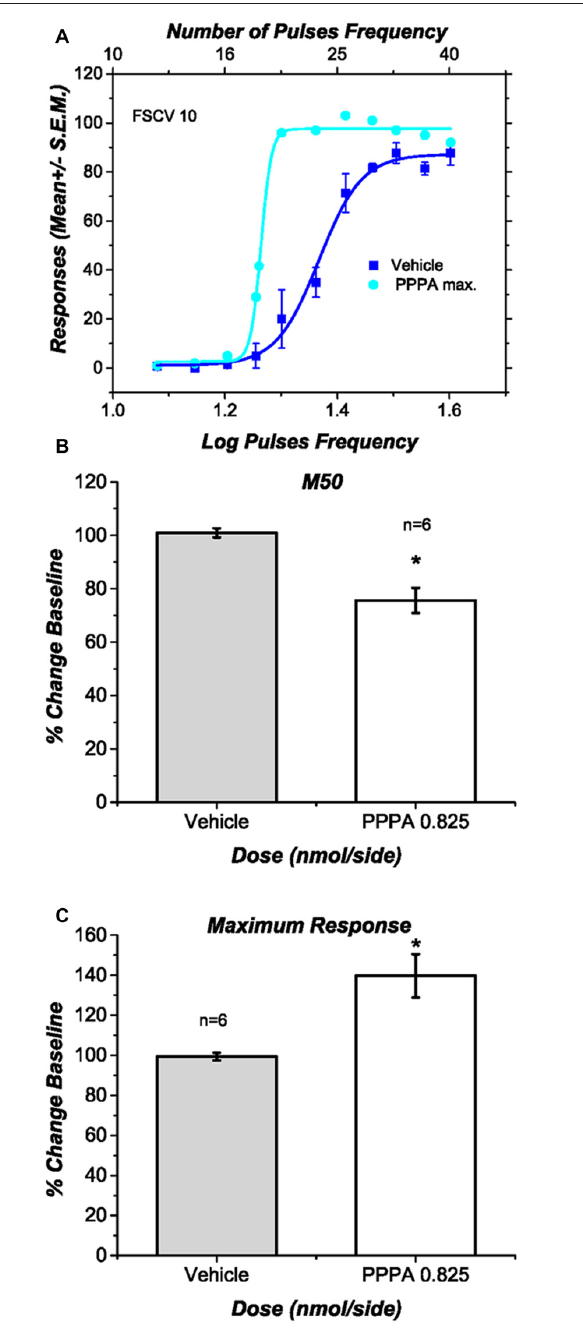
FIGURE 4 | Effects of intra ventral midbrain (VM) (2R,4S)-4-(3-Phosphopropyl)-2-piperidinecarboxylic acid (PPPA) injection on behavior. (A) In one representative subject intra VM injection of PPPA shifted the response-rate vs. pulse-frequency curve leftward and increased its upper asymptote. (B) The bar graph shows a significant reduction in M50 value in all the behaviorally trained subjects in which DA release was successfully measure. The reduction in M50 value suggests an increase in the effectiveness of the stimulation to elicit nose-poke behavior. (C) The bar graph shows a significant increase in the maximum response rate elicited by intra VM injection of